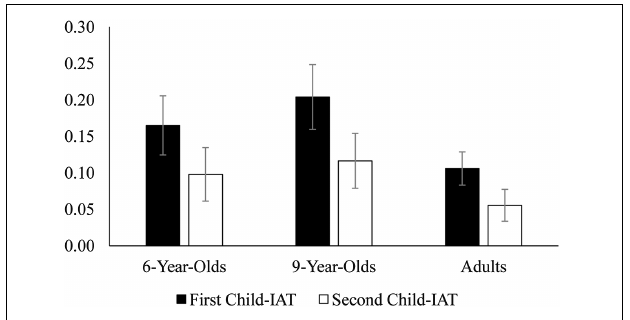
FIGURE 1 | Mean Implicit Association Test (IAT) D scores by age group and order of measure (Study 2). Error bars represent standard error.